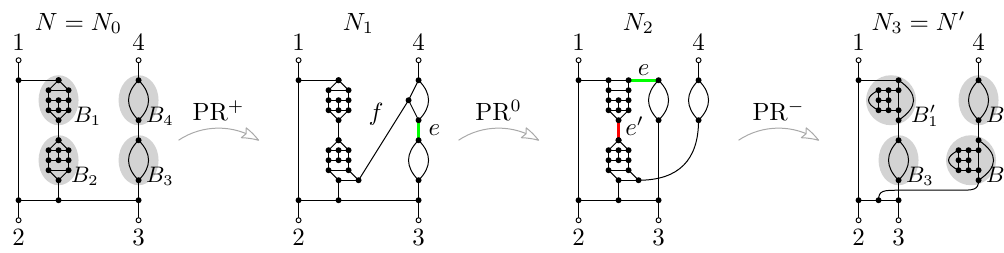
Figure 15: A length three PR-sequence from N to N (cid:48) that uses a PR + , which adds f , a PR 0 , which moves e , and a PR − , which removes e (cid:48) . A PR 0 -sequence from N to N (cid:48) has length at least four.